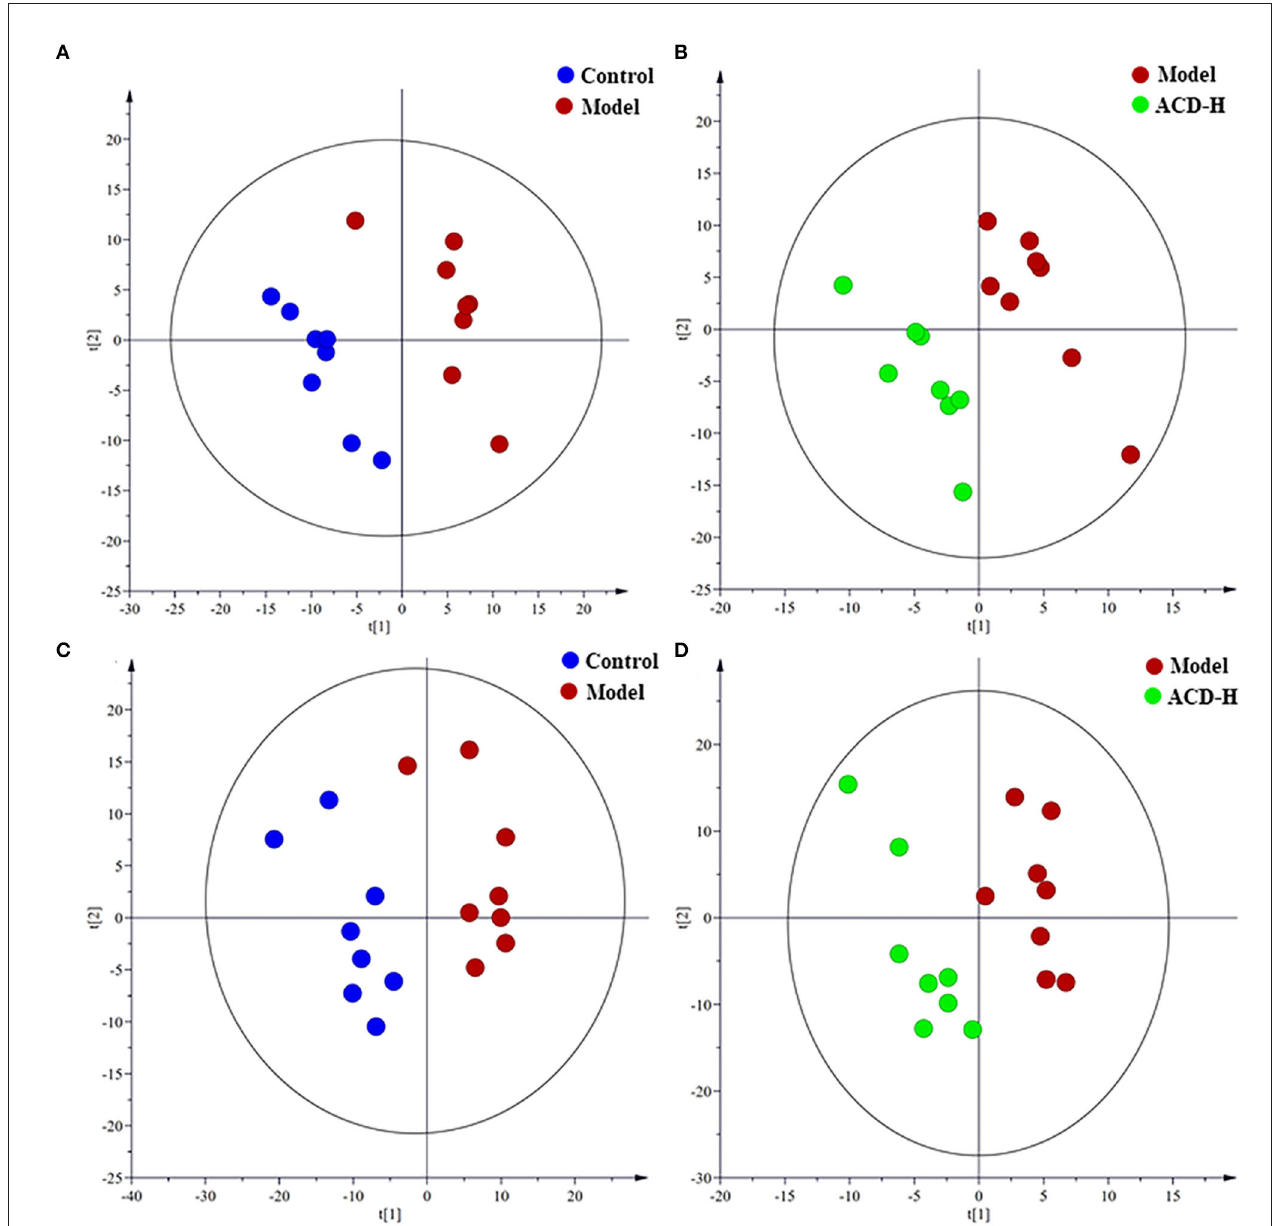
FIGURE 4 | Partial least-squares discriminant analysis (PLS-DA) score plots of the laying hens in control, model and ACD-H groups ( n = 8). (A,B) PLS-DA score plots in positive mode; Control vs. model: R 2 X = 0.32, R 2 Y = 0.90 and Q 2 = 0.28; Model vs. ACD-H: R 2 X = 0.24, R 2 Y = 0.93 and Q 2 = 0.22. (C,D) PLS-DA score plots in negative mode; Control vs. model: R 2 X = 0.38, R 2 Y = 0.88 and Q 2 = 0.51; Model vs. ACD-H: R 2 X = 0.30, R 2 Y = 0.90 and Q 2 = 0.15. Clear separation without overlap was observed among control, model and ACD-H